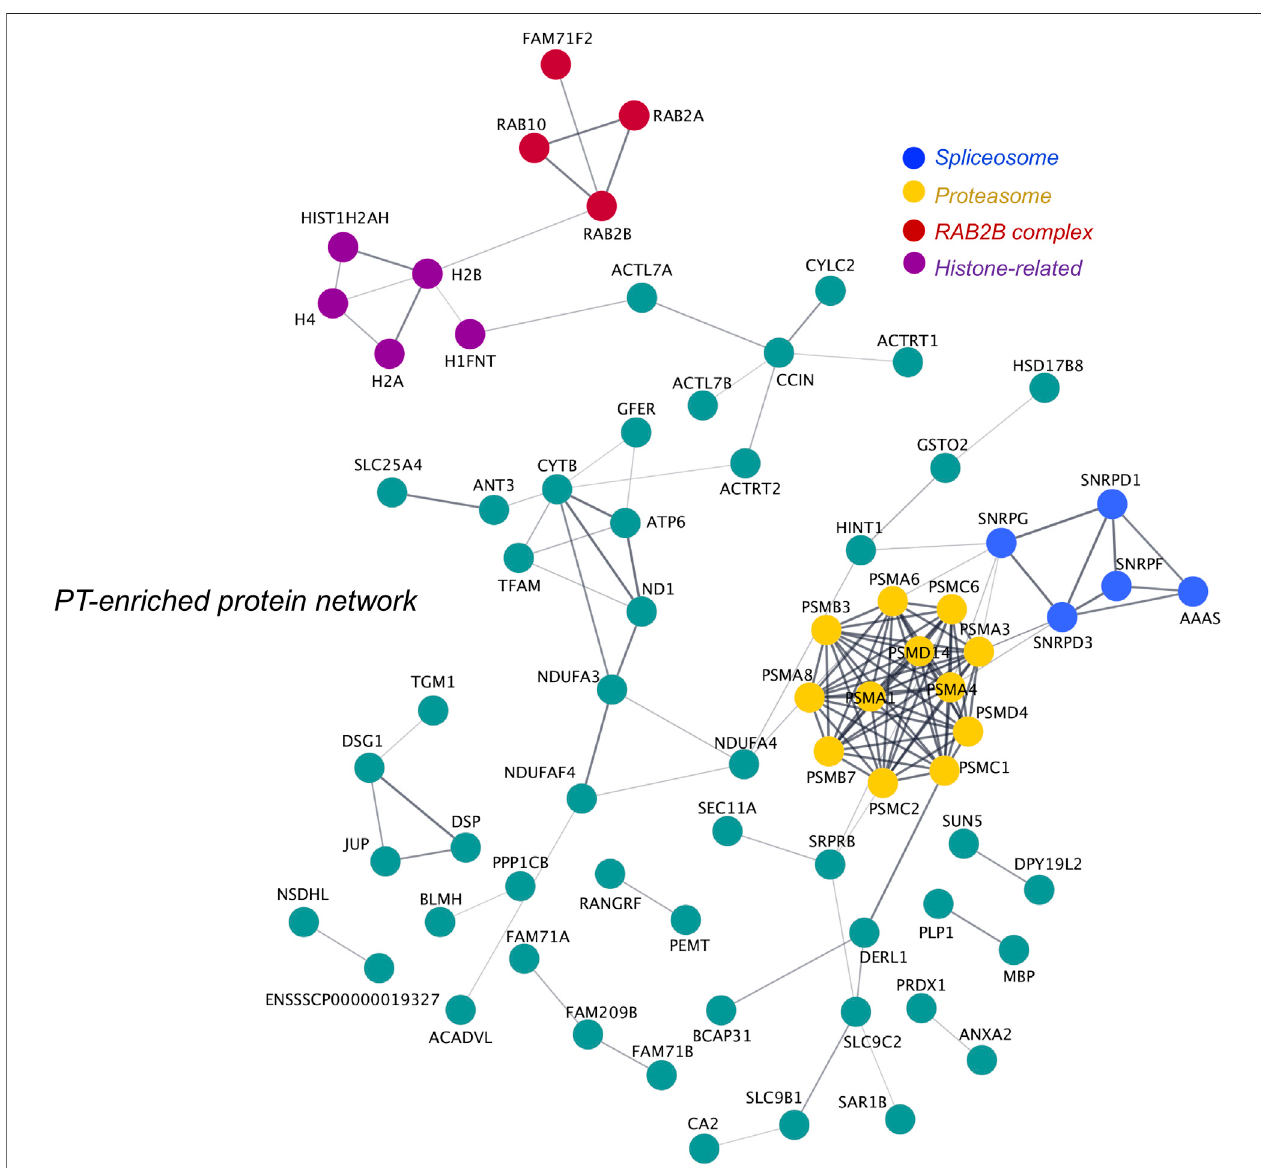
FIGURE 8 | Protein network analysis of the perinuclear theca and identi fi cation of key protein clusters. All proteins deemed to be enriched in the perinuclear theca (PT)comparedtothespermheadandtailweresearchedintheonlineproteininteractiondatabaseString via their Susscrofa UniProtproteinaccessionsalongsidethe19 proteins that were found to be unique to the PT compared to the head and tail. The protein network formed by the PT proteins was then exported to Cytoscape and protein clusterswere manually designated functional annotationsbased on literature searches conducted on their protein components. This analysis revealed four proteins clusters enriched in proteins related to the “ proteasome ” (yellow) and “ spliceosome ” (blue), somatic histones (histone-related; purple), RAB proteins (RAB2B complex; red). Single proteins that did not interact with other PT proteins within the network feature in Supplementary Figure S1A .